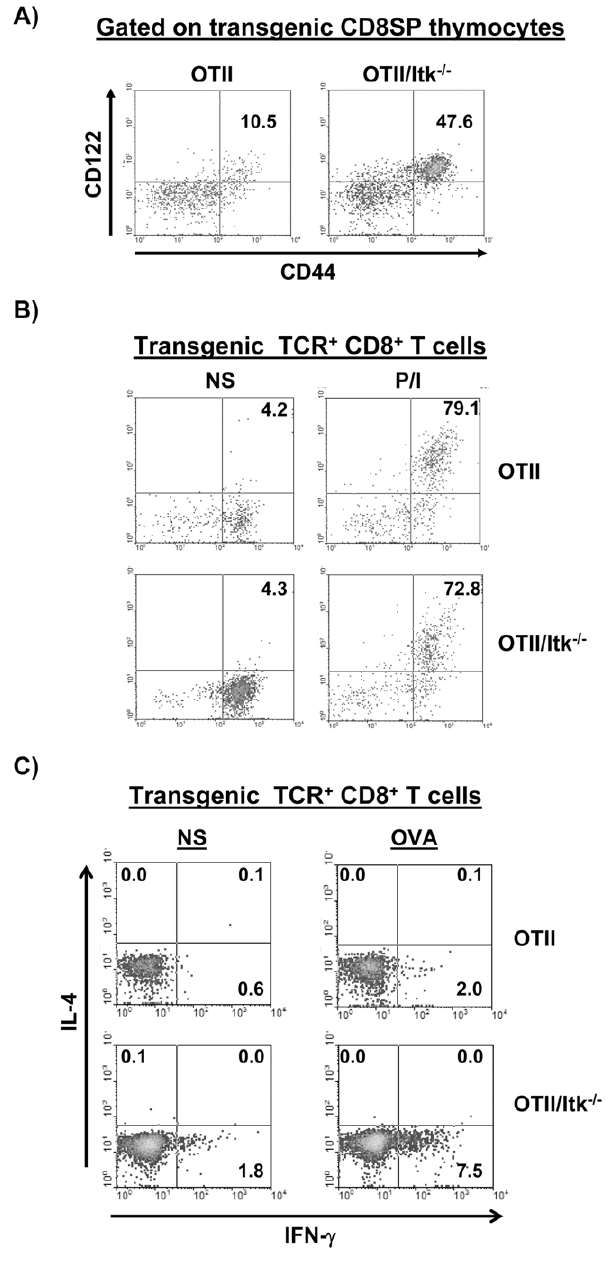
Figure 8. TCR transgene positive CD8 T cells that develop in OT-II/Itk 2 / 2 have characteristics of ‘‘non-conventional’’ or ‘‘innate memory phenotype’’ CD8 T cells. ( A ) TCR transgene positive CD8SP thymocytes from OT-II or OT-II/Itk 2 / 2 were analyzed for CD44 or CD122 by flow cytometry. ( B ) Splenocytes from OT-II or OT-II/ Itk 2 / 2 mice were stimulated with PMA and Ionomycin for 6 hours, followed by analysis of TCR transgene positive CD8 + T cells for expression of CD44 and IFN- c . ( C ) Splenocytes from OT-II or OT-II/Itk 2 / 2 mice were stimulated with OVA peptide in vitro, followed by analysis of TCR transgene positive CD8 + T cells for expression of IL-4 or IFN- c